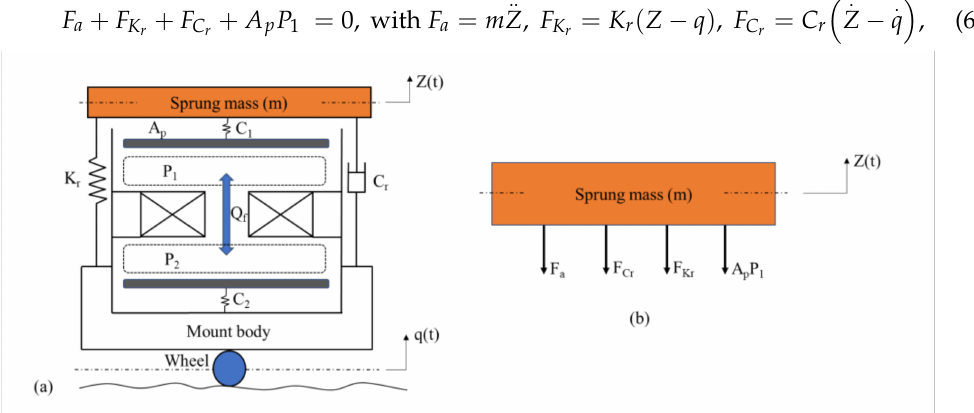
Figure 3. Dynamic model: ( a ) a quarter-car suspension system; ( b ) the active force on the sprung